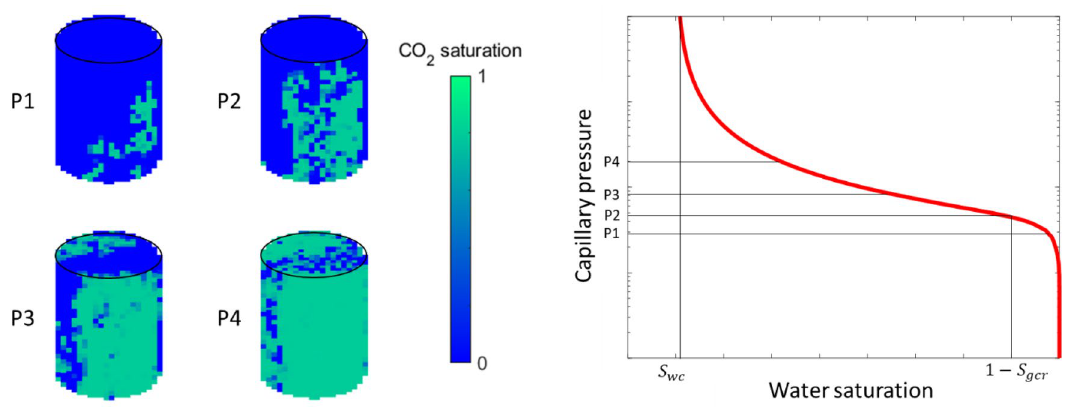
Figure 1. Illustration of buoyancy-driven CO 2 invading a water-saturated core from the bottom. Left: CO 2 saturation fields at increasing capillary pressure values. Right: The resulting drainage capillary pressure curve. S wc : Irreducible water saturation. S gcr : Critical CO 2 saturation. P2: Threshold capillary